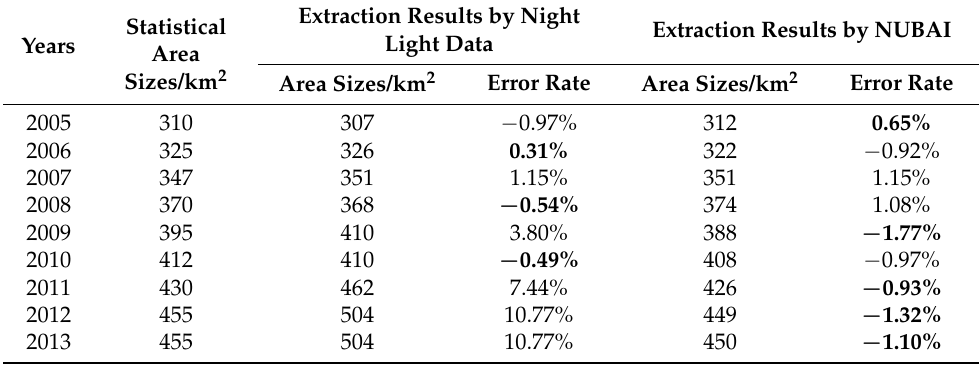
Table 1. Error analysis of the area sizes from 2005 to 2013.